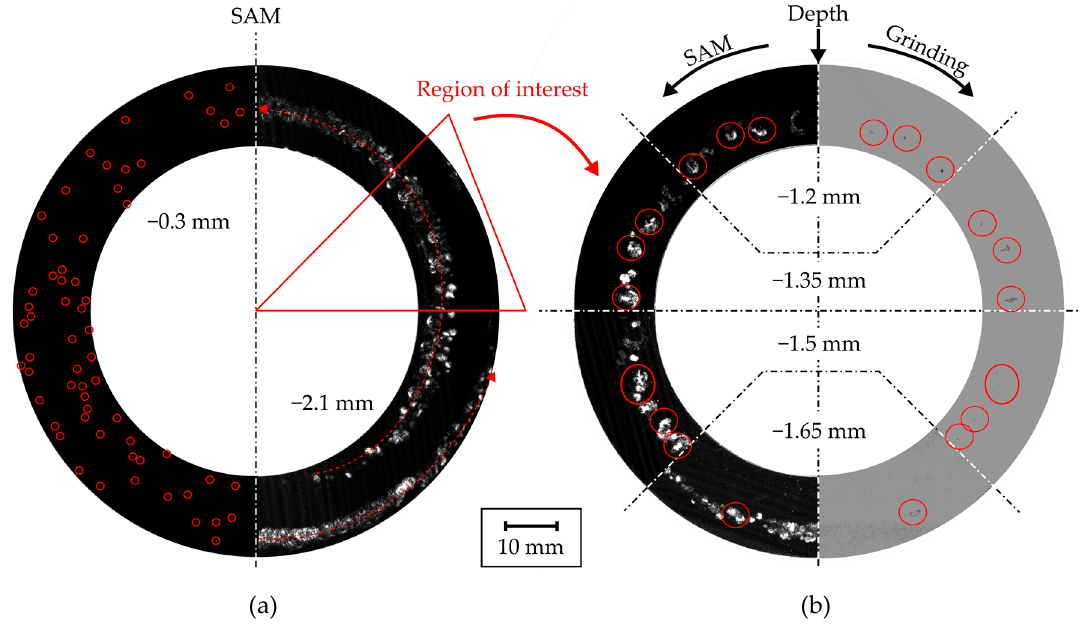
Figure 12. Scanning acoustic microscope images before testing: ( a ) Smaller pores near the surface (left) and larger cavities in the material transition zone (right); ( b ) comparison of scanning acoustic microscopy (SAM) (left) and optical microscopy after grinding (right) for different depths.